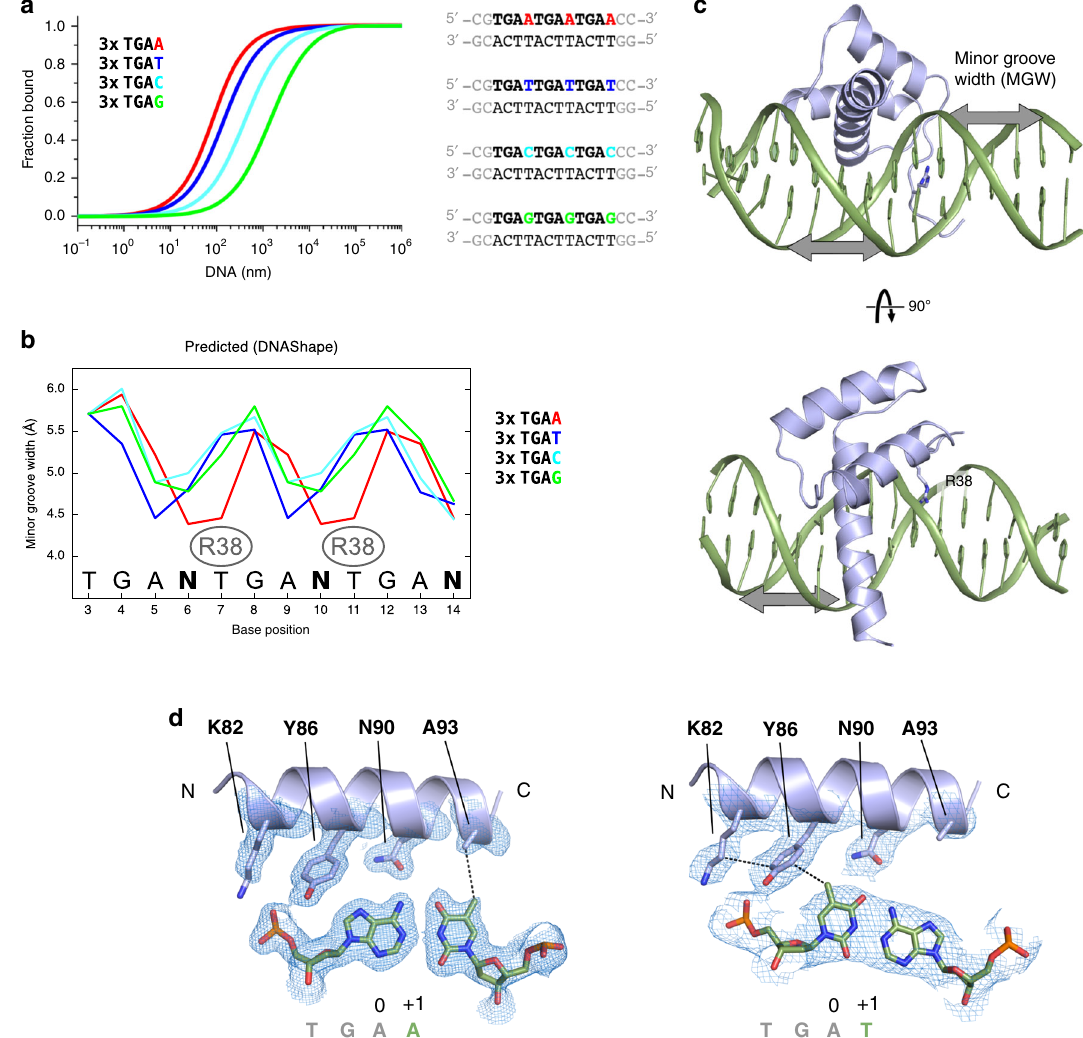
Fig. 4 Molecular basis for preference of the + 1 recognition motif position. a MST-analysis of WUS sequence recognition speci fi city for DNA position + 1, based on an atypical recognition motif. The tandem recognition motif is in bold letters and position + 1 is adenine (red), thymine (blue), cytosine (cyan), and guanine (green). b Predicted minor groove width (MGW) pro fi les for atypical DNA sequences differing only in the + 1 position of the WUS-HD recognition sequence. The color scheme is the same as in ( a ) and the binding position of WUS R38 inserting into the minor groove is indicated. The DNA sequence is shown at the bottom, where N represents any of the four nucleotides (A,T,C,G). c Structure of WUS (light blue) bound to DNA (green) highlighting the insertion of R38 into the minor groove. The minor groove width (MGW) is indicated by gray arrows. d Structural basis of adenine (TGAA, left) and thymine (G-Box, right) preference at the + 1 position. Shown are the residues of the WUS recognition helix making hydrophobic contacts with the C5 methyl group of thymine. The conserved Asn90 residue is shown as a reference and the 2Fo – Fc electron density maps (blue mesh) are contoured at 1.0 σ